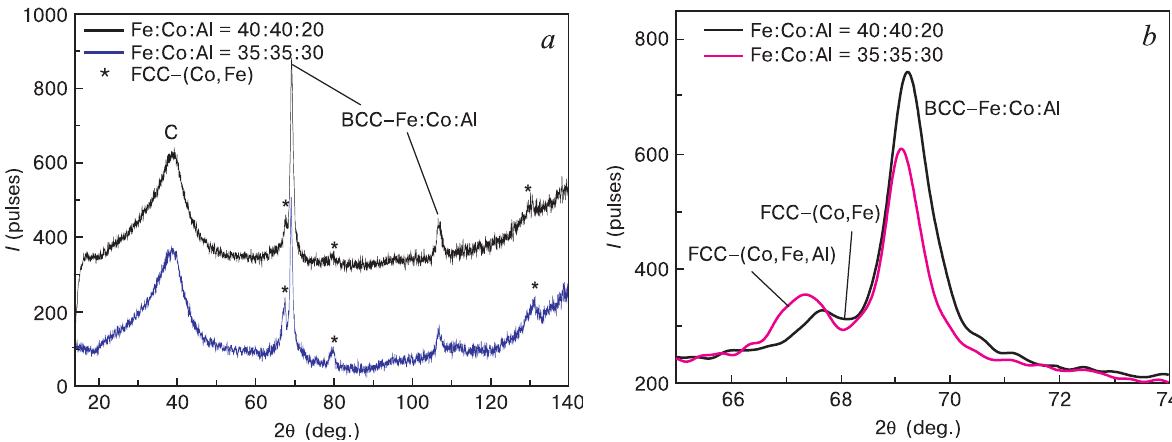
Figure 2. ( a ) X-ray diffraction patterns of nanocomposites and ( b ) fragment of X-ray diffraction pattern near 2θ = 65°÷74° for dif - ferent ration of metal weights Fe : Co : Al ( Т synth = 700